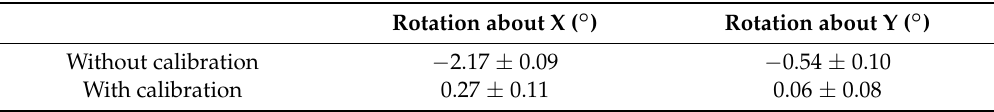
Figure 19. Calibrated orientation estimates for ground truth relative orientation of a surface with 0° rotation about both the X and Y axes. Table 2. Average value and standard deviation on the surface orientation relative to the compliant wrist, without and with calibration, and ground truth orientation of 0° about both axes.